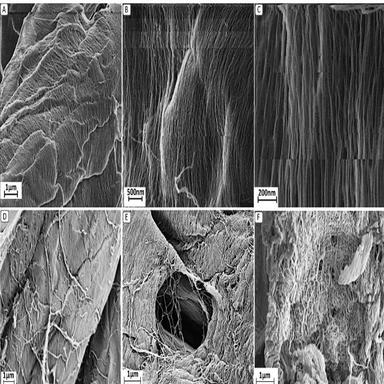
Various HIM micrographs on birch never dried, CPD treated pulp taken with a longer exposure time (3e5 min): a,b,c) individual nanofibrils and nanofibril bundles clearly visible.